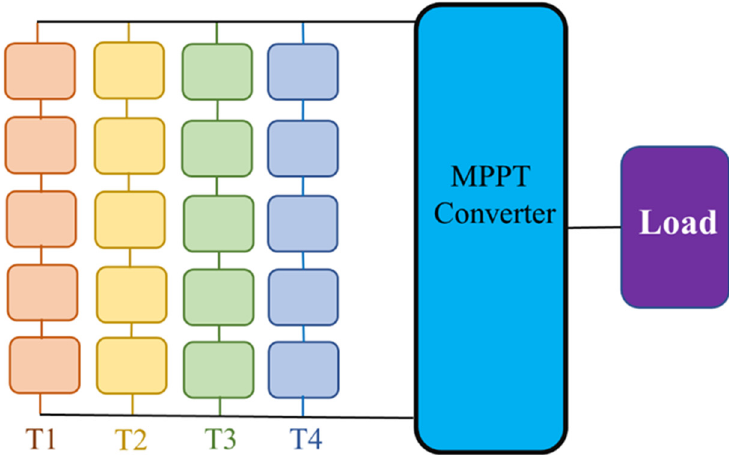
Figure 2. TEG module structure with equivalent electrical circuit.